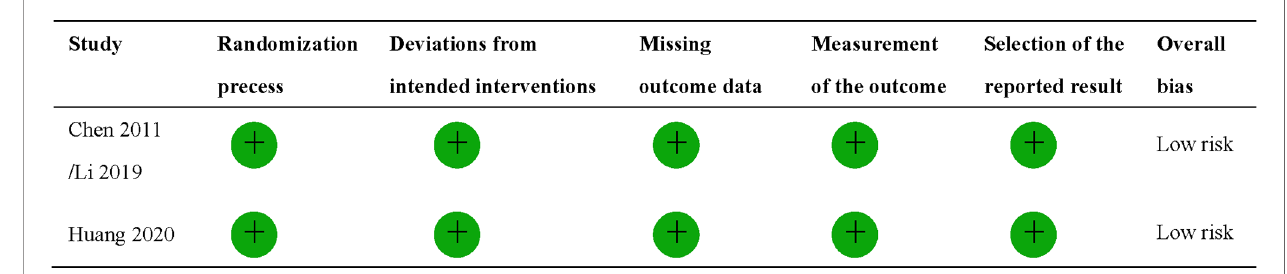
FIGURE 2 | Assessment of quality of randomized